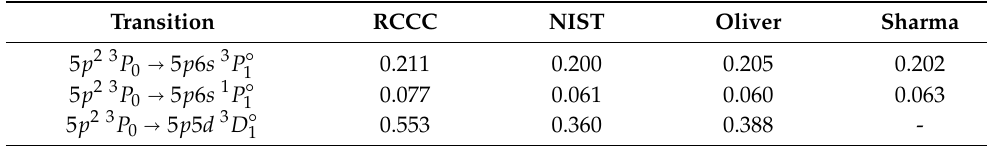
Table 2. Oscillator strengths (in length form and atomic units) for the ground state of tin. RCCC values are compared with NIST [10], Oliver and Hibbert [11] and Sharma et al. [8]. Transition RCCC NIST Oliver